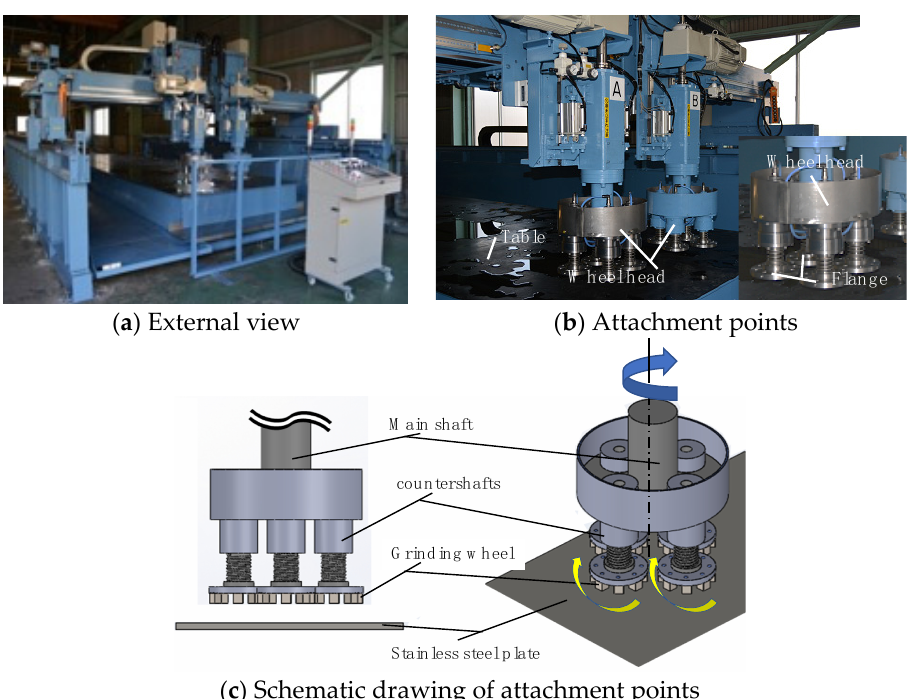
Figure 1. Developed wet grinding machine and attachment points for the grinding wheels.